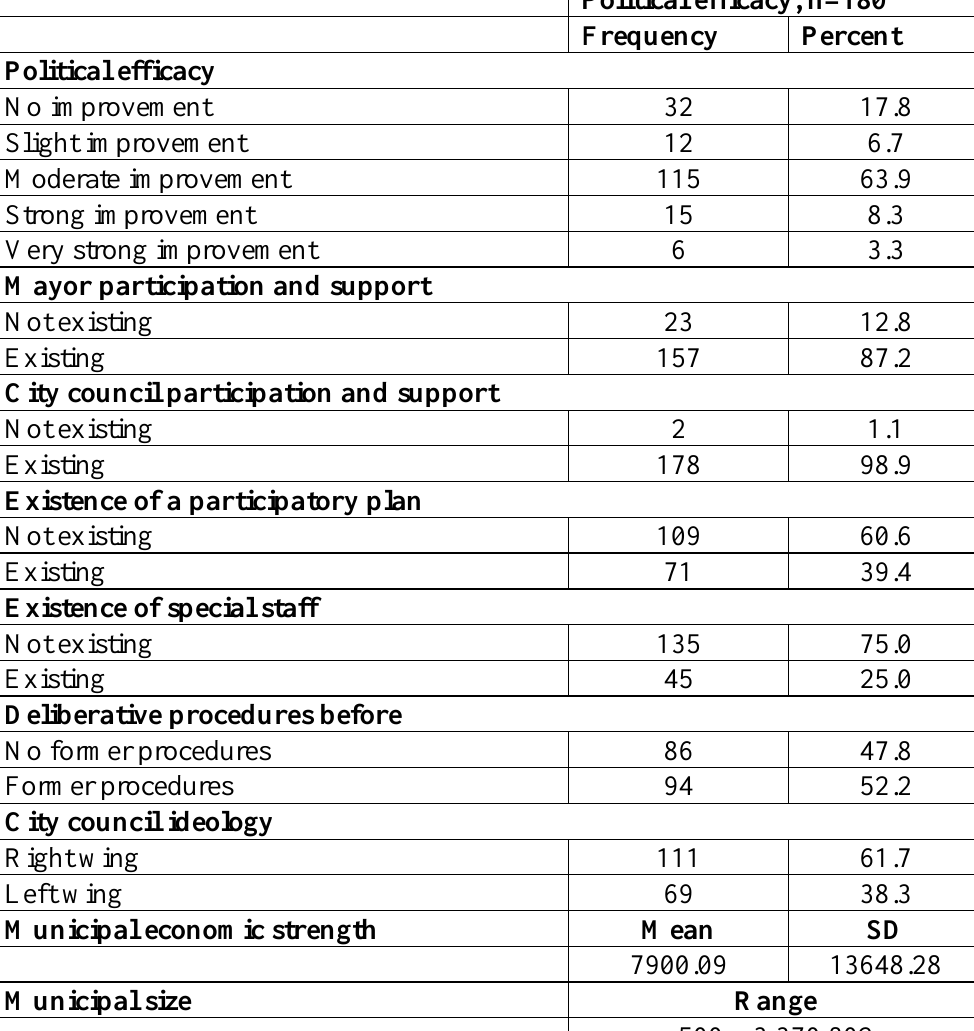
Table 3. Descriptive overview of dependent and independent